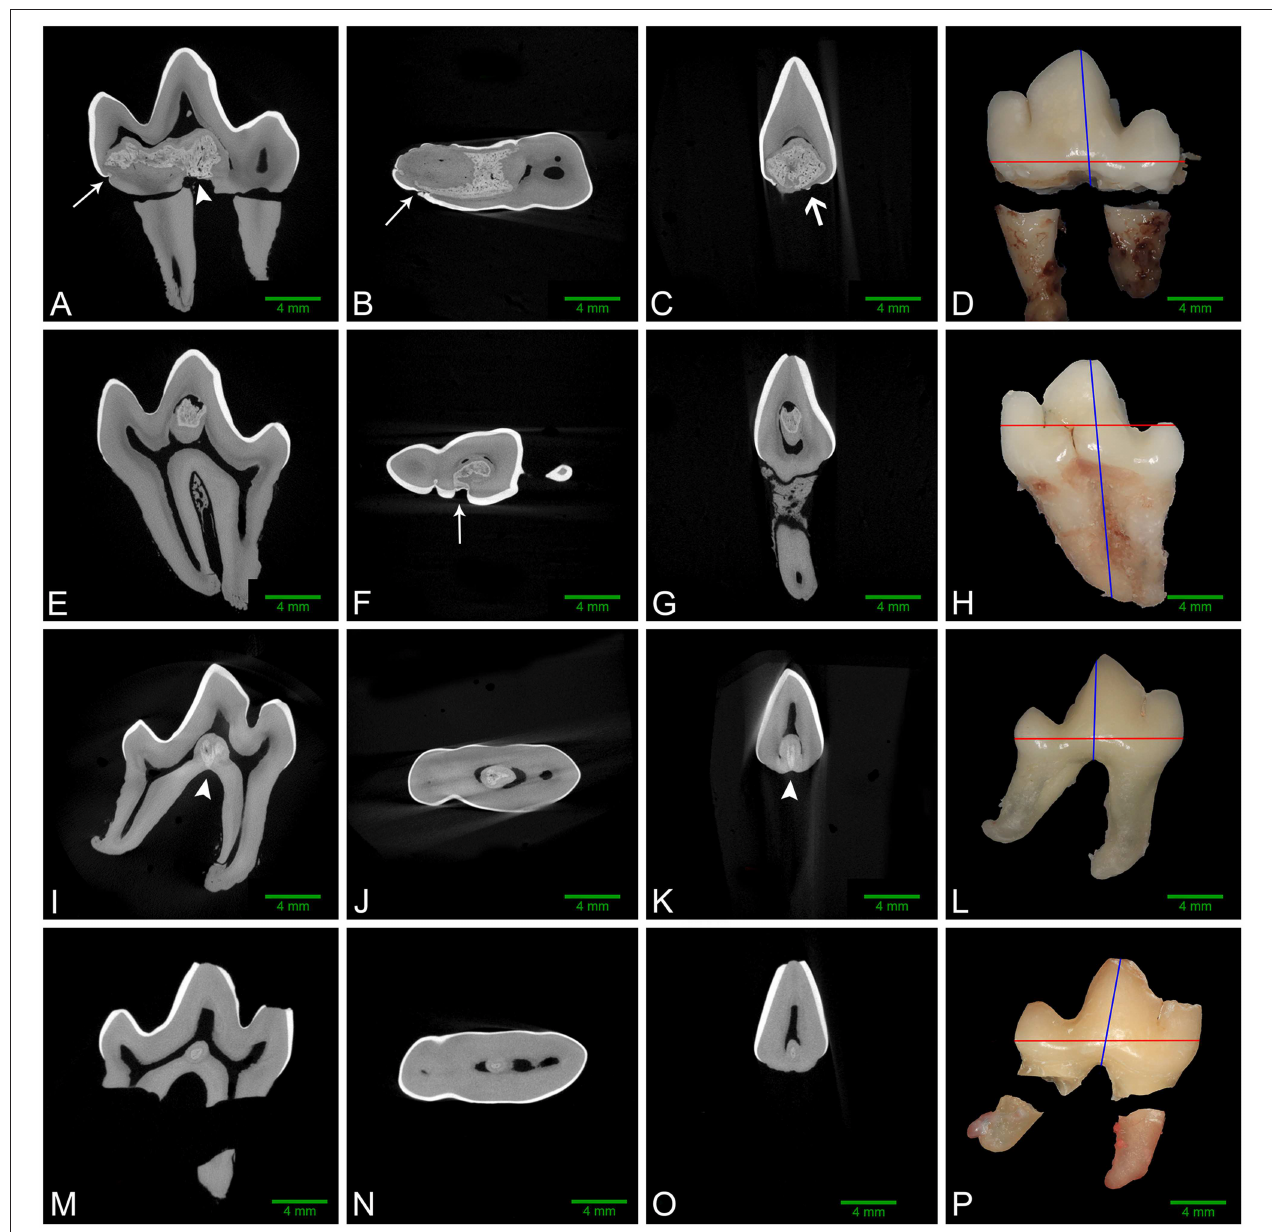
FIGURE 3 | Left to right: sagittal, dorsal, and transverse micro-CT reconstructions along with gross images of the buccal aspect of affected mandibular first molar teeth. Red and blue lines on the gross images denote the plane of dorsal and transverse sections, respectively. (A–D) Left mandibular first molar tooth from dog 1. The abnormal tissue occupies a large region of the pulp chamber floor and communicates with multiple enamel fissures (white arrows), as well as the furcation (white arrowhead). A small focus of ectopic enamel is also visible (open white arrow), and a free-floating pulp stone is present in the central pulp horn. (E–H) Left mandibular first molar tooth from dog 3. Abnormal tissue occupies a large area of the central pulp horn and communicates with a large enamel fissure on the buccal aspect of the crown (white arrow), with no contact with the furcation. (I–L) Right mandibular first molar tooth from dog 4. The lesion in the central pulp chamber floor contacts the furcation (white arrowheads), but not the coronal enamel. (M–P) Right mandibular first molar tooth from dog 5. The small lesion on the floor of the pulp cavity has no identifiable contact with enamel or the radicular